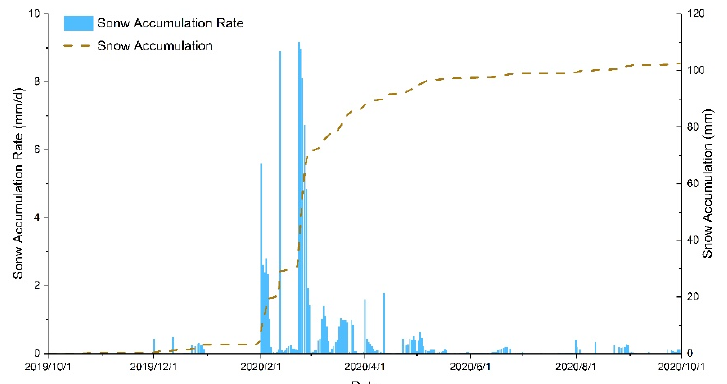
Figure 8. The snow accumulation rate and total snow accumulation curve over iceberg D28 from